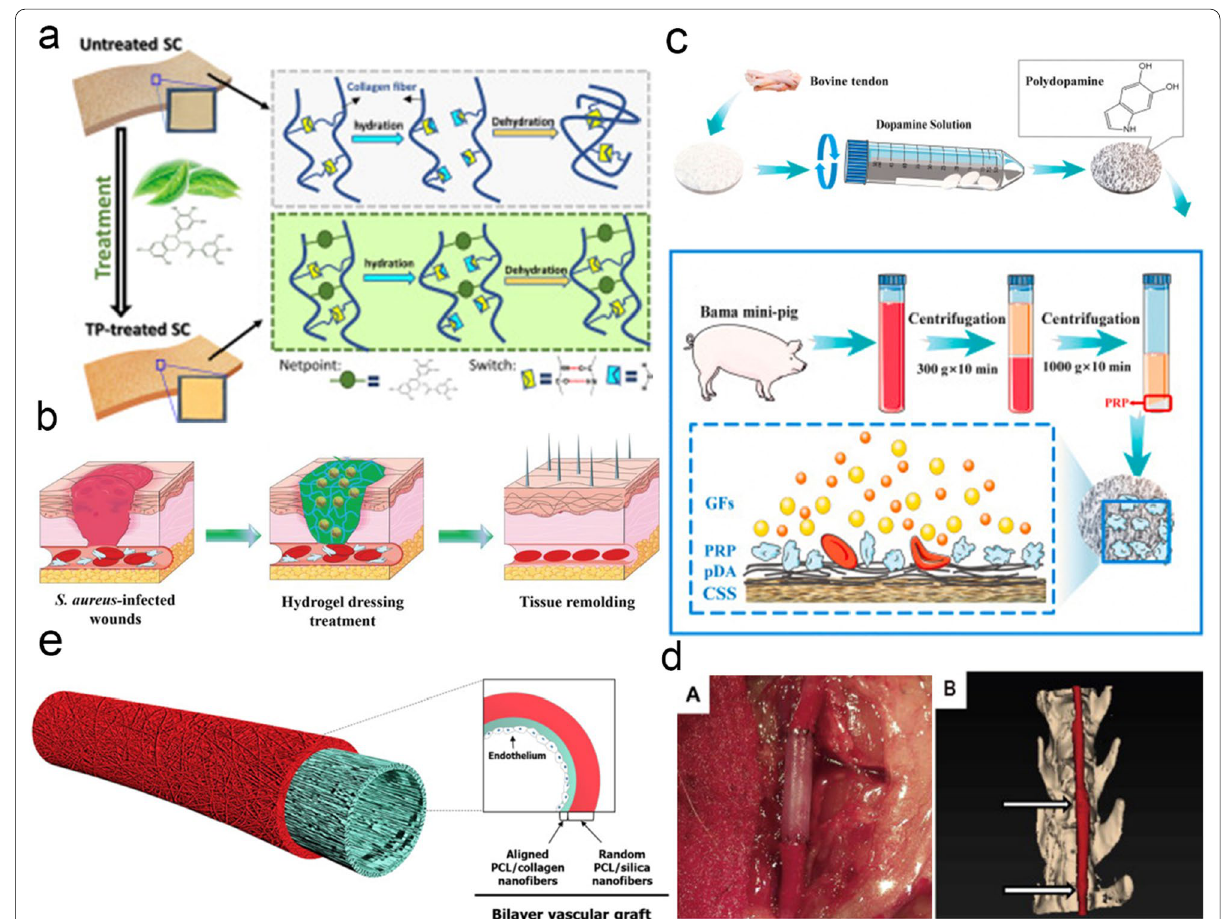
Fig. 7 Application of collagen in regeneration of skin tissue and cardiovascular repair. a A tea-polyphenol treated skin collagen. Reproduced with permission from [135]; b Diagram of accelerating wound healing based on CS-based hydrogels functionalized by CA-TA-ZA NSs. Reproduced with permission from [138]; c Polydopamine-modified collagen sponge scaffold as a novel dermal regeneration template with sustained release of platelet-rich plasma to accelerate skin repair. Reproduced with permission from [136]; d Acellular vascular grafts generated from collagen and elastin analogs. Reproduced with permission from [20]; e Schematic illustration of the electrospun bilayer vascular graft with an aligned PCL/ collagen inner layer and a randomly distributed PCL/silica outer layer. Reproduced with permission from